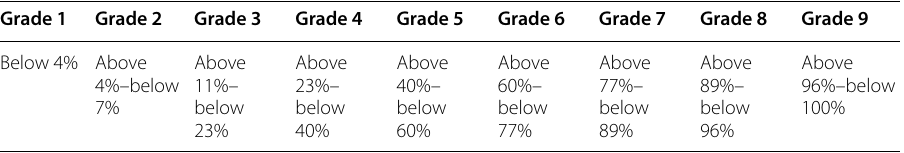
Table 2 Share of each grade in relative standard (normal distribution) Grade 1